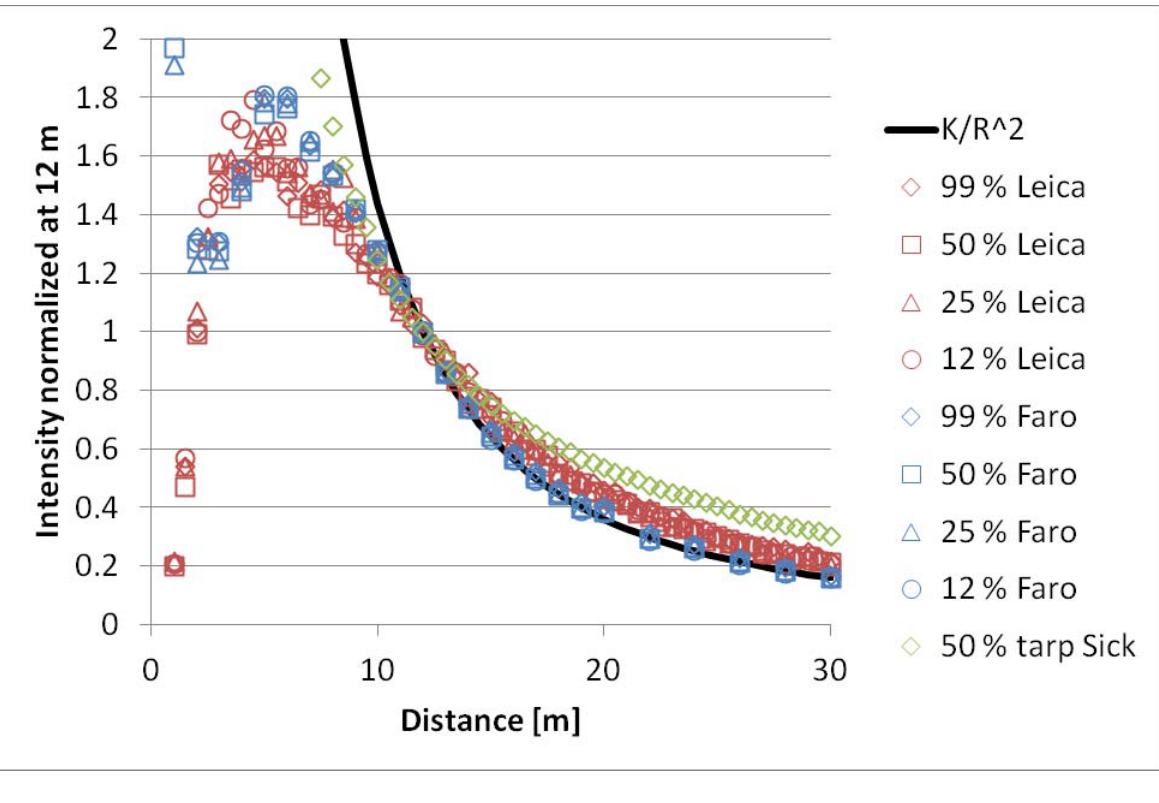
Figure 6. The K/R 2 function (scaled to K/R 2 = 1 at R = 12 m ) plotted over intensity vs. range data, all scaled to equal 1 at 12